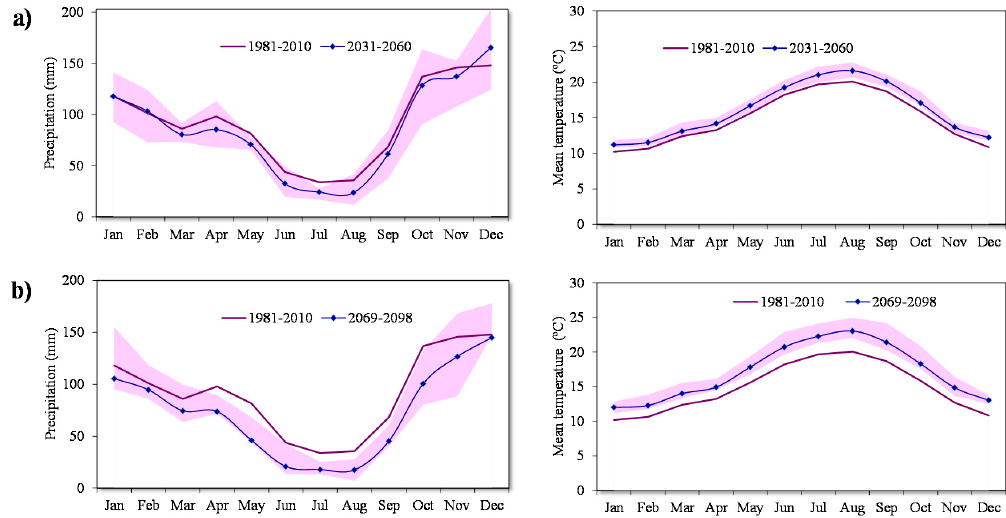
Figure 2. Current monthly rainfall and mean temperature in the study area and projections of climate change for ( a ) 2031–2060 and ( b ) 2069–2098. The shaded area shows the range of climate model predictions for the study area. The line represents the mean.